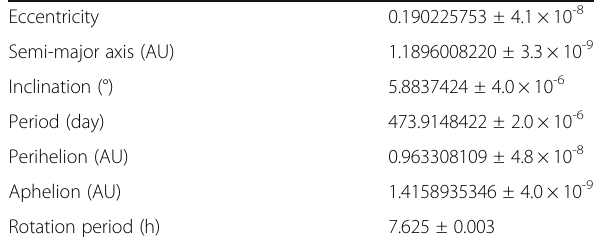
Table 1 Summary of important orbital and global properties. The orbital data are taken from JPL ’ s SSD website (NASA ’ s Jet Propulsion Laboratory Solar Systems Dynamics Group - HORIZONS at http://ssd.jpl.nasa.gov/). Rotation period is from numerous references (Kim et al. 2013; Müller et al. 2017; Perna et al.